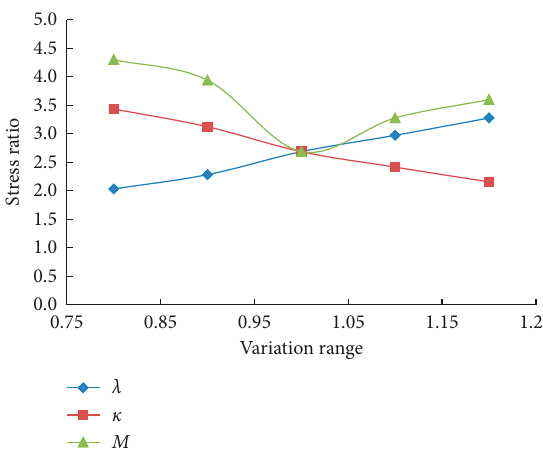
Figure 9: Stress ratio-parameter